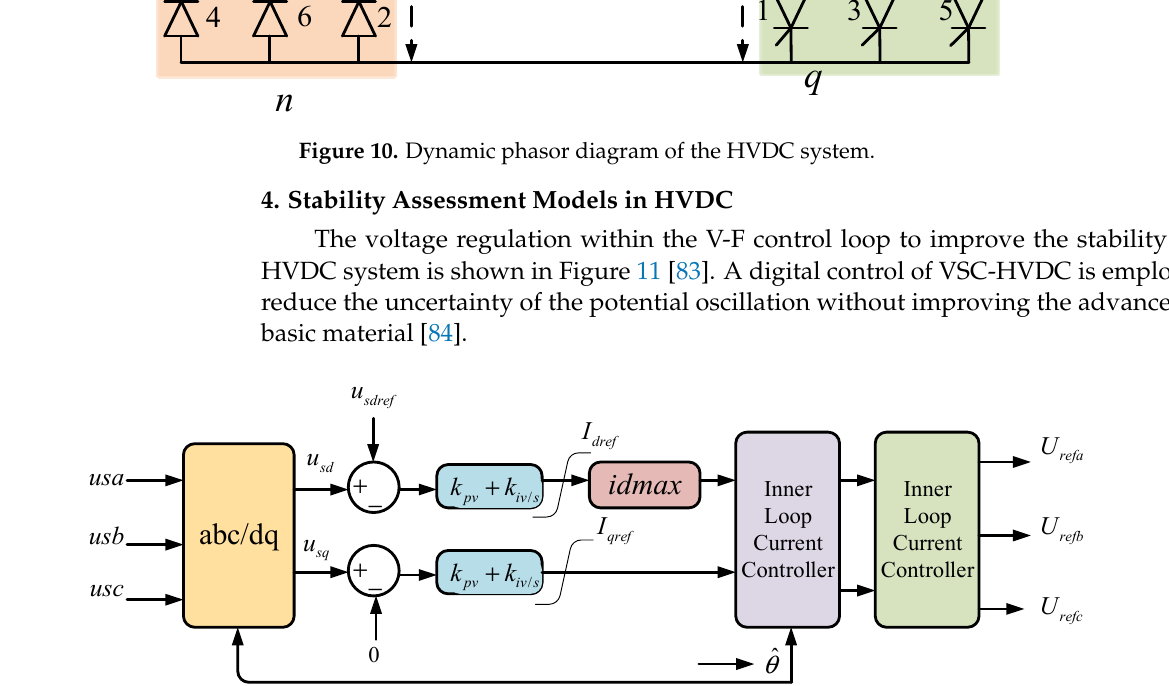
Figure 11. The voltage regulation in the V-F control loop.